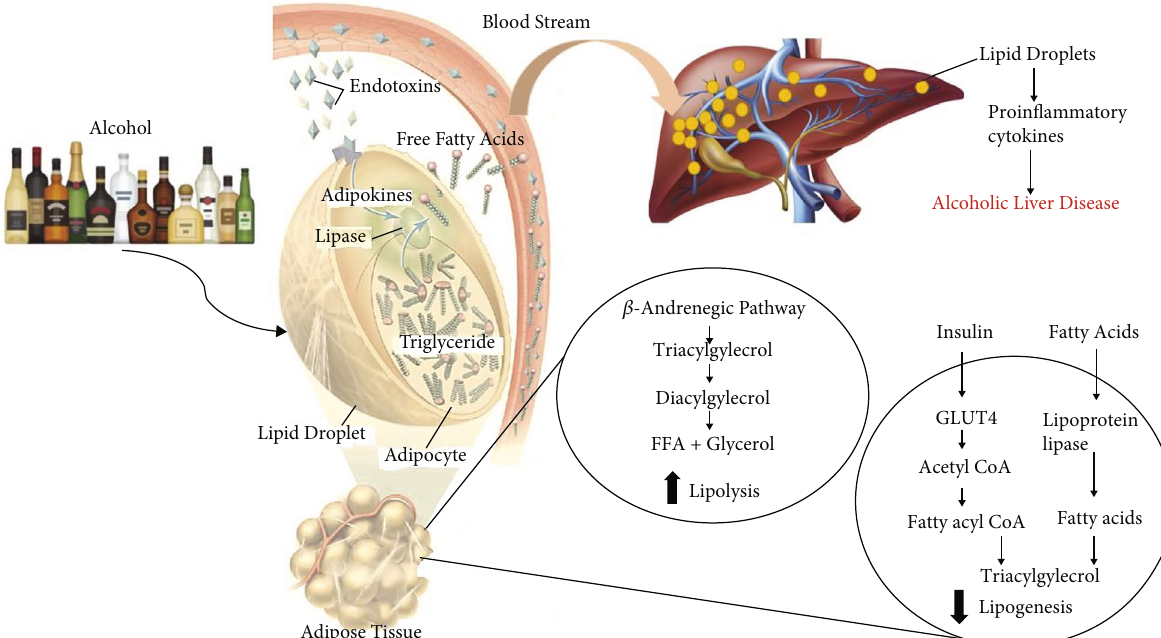
Figure 1: E ff ect of ethanol on adipose tissue contributing to the advancement of alcoholic liver disease